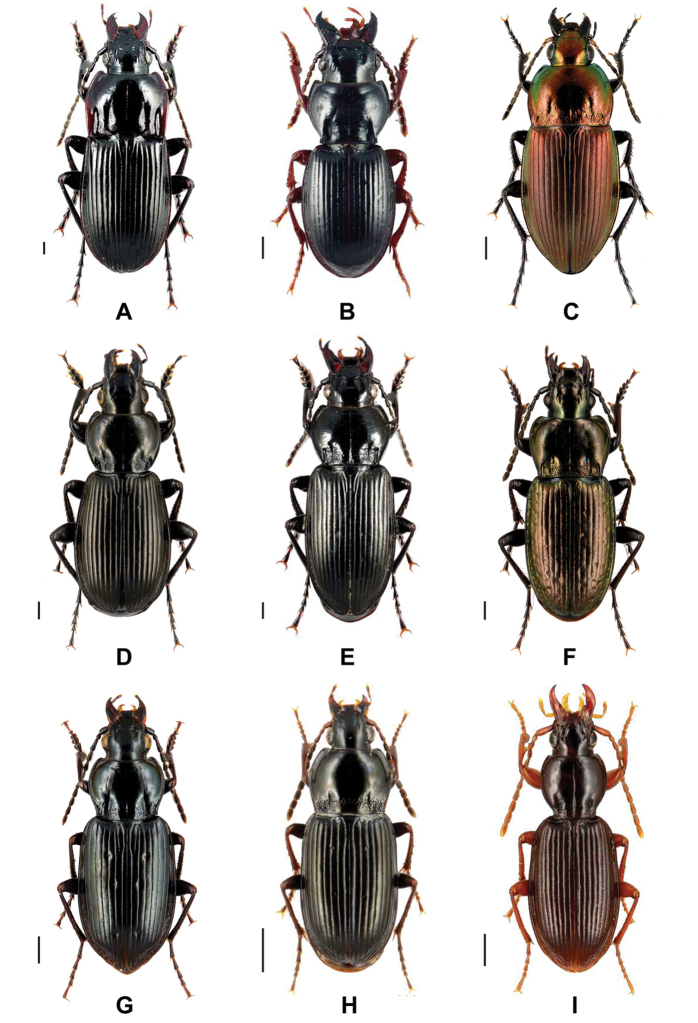
Representative images of analyzed beetle species AAbax
parallelepipedus (Piller & Mitterbacher, 1783) BMolops
piceus (Panzer, 1793) CPoecilus
versicolor (Sturm, 1824) DPterostichus (Eosteropus) aethiops (Panzer, 1796) EPterostichus (Omaseus) melanarius (Illiger, 1798) FPterostichus (Oreophilus) multipunctatus (Dejean, 1828) GPterostichus (Bothriopterus) quadrifoveolatus Letzner, 1852 HPterostichus (Argutor) vernalis Panzer, 1796 and IStomis
pumicatus (Panzer, 1795). Scale bars: 1 mm. All images were obtained from www.eurocarabidae.de.